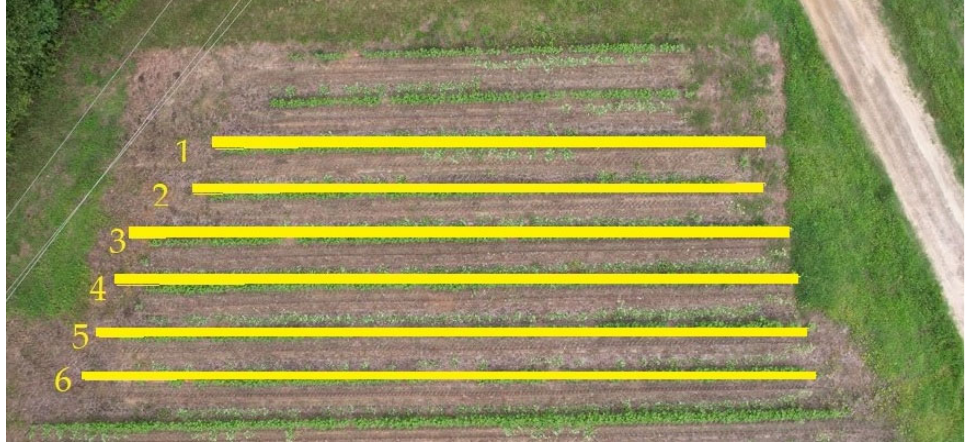
Figure 4. Cotton planted in Field 2.